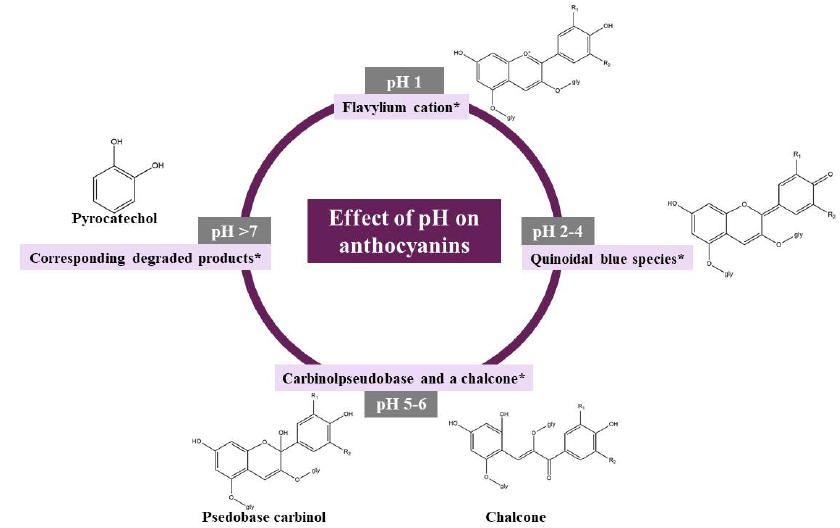
Figure 4. Anthocyanins at different pH values, * predominant chemical form [42].